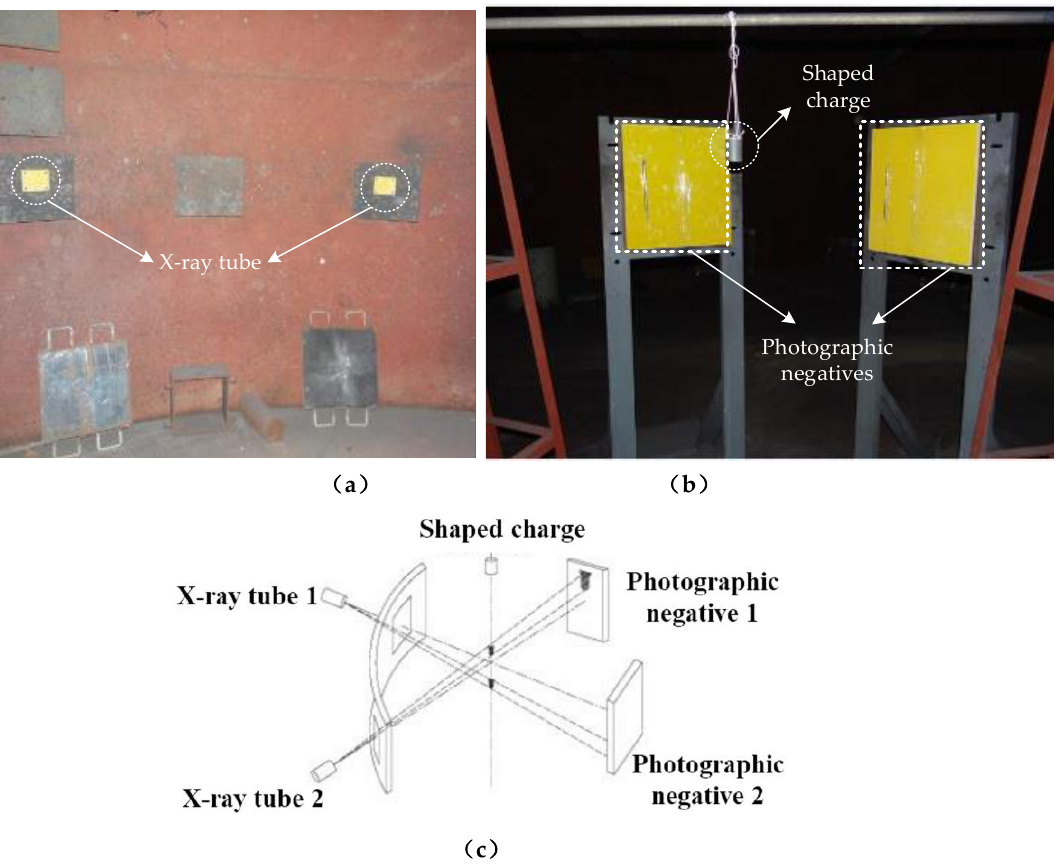
Figure 13. Field layout of pulse X-ray test: ( a ) Test scene graph; ( b ) Test layout; ( c ) Pulse X-ray test principle.